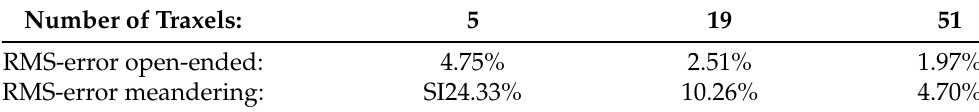
Table 3. Root-mean-square (RMS) errors for the errors in Figures 16 and